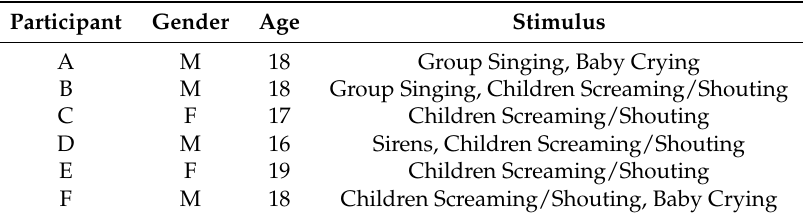
Table 1. Participant demographics including identified problematic